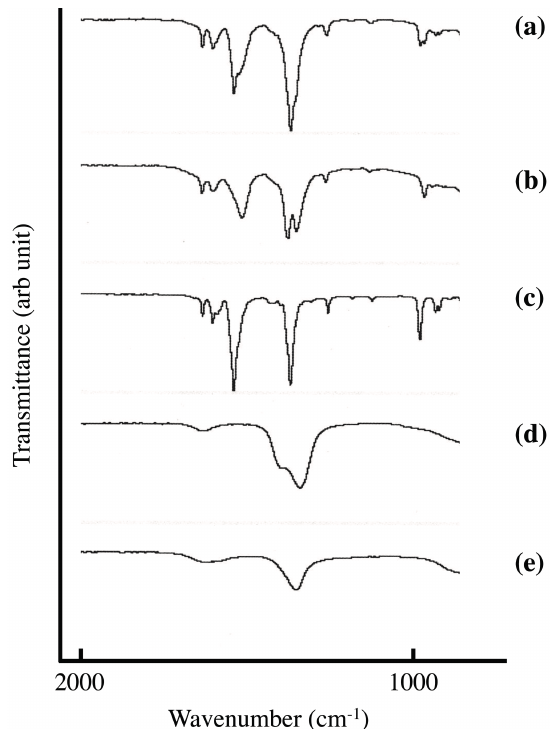
) ground with 1.3 mmol of SA-K per 1 3